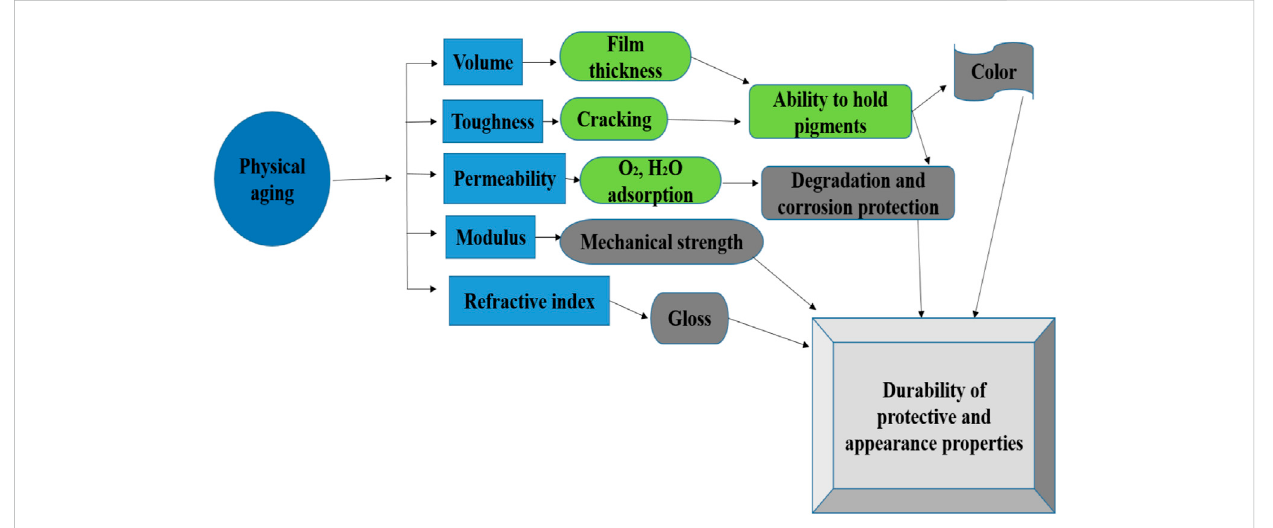
FIGURE 1 Potential in fl uence of physical aging on the coating ’ s